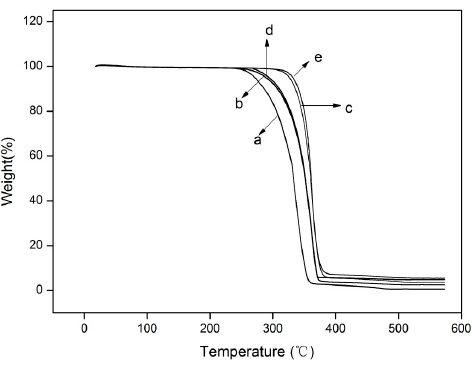
Figure 6. TGA curves of the PLA/NPs blend films: (a) PLA, (b) PLA/Ti1%, (c) PLA/Ti5%, (d) PLA/Ti1%/Ag, and (e) PLA/Ti5%/Ag.